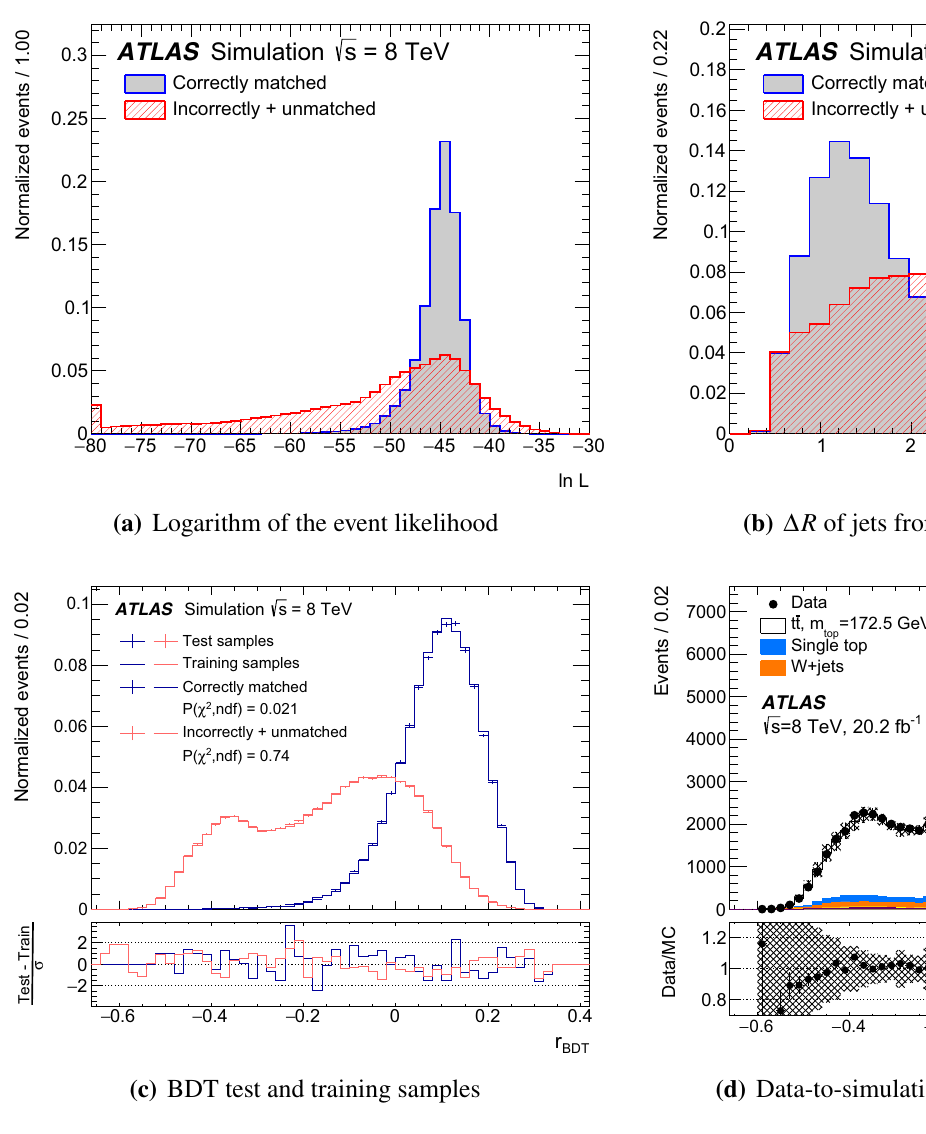
Fig. 2 Input and results of the BDT training on t ¯ t signal events for the preselection. a shows the logarithm of the event likelihood of the best permutation (ln L ) for the correctly matched events and the remainder. Similarly, b shows the distribution of the (cid:10) R between the two untagged jets assigned to the W boson decay. c shows the distribution of the BDT output ( r BDT ) for the two classes of events for both the training (his- tograms) and test samples (points with statistical uncertainties). The compatibility in terms of the χ 2 probability is also listed. The distri-